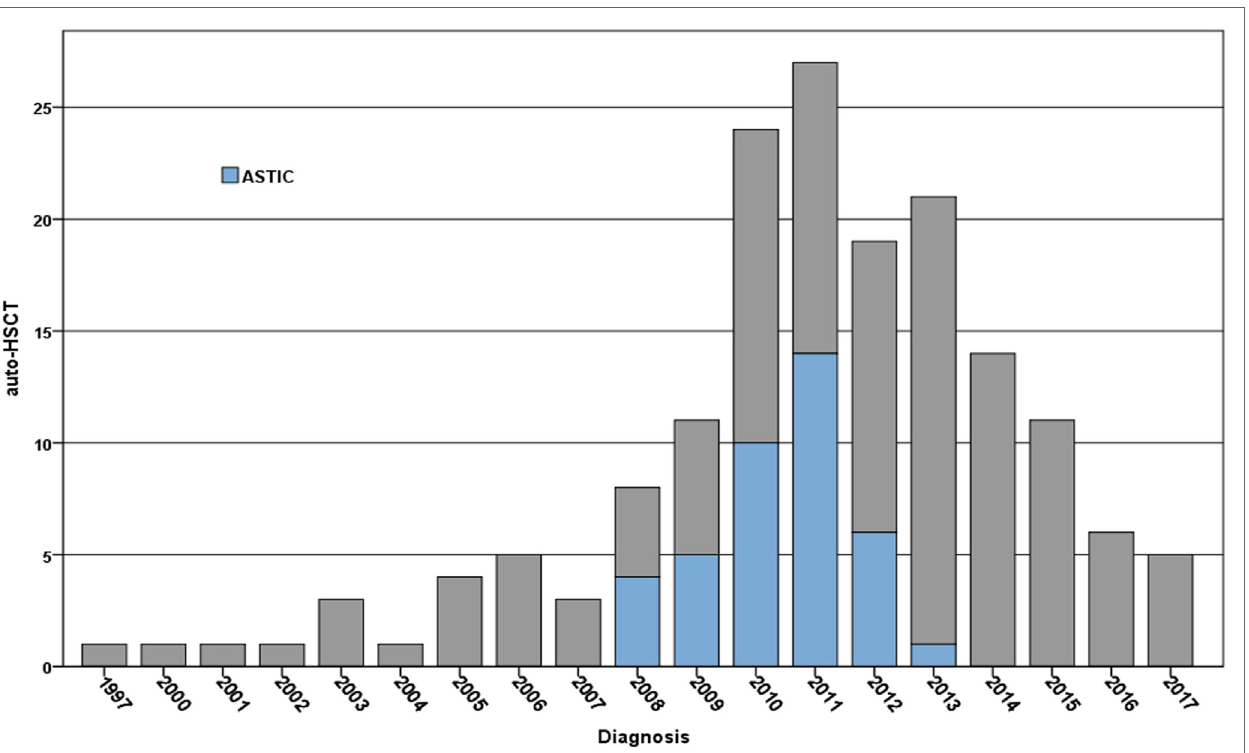
FiGURe 1 | Registrations per year for the treatment of Crohn’s disease using autologous hematopoietic stem cell transplantation (auto-HSCT) within the EBMT registry 1994–2017 (note data for 2017 up to November 2017)—numbers treated on the Autologous Stem cell Transplantation International Crohn’s disease (ASTIC) trial are indicated in blue. Patients have been predominantly treated in Spain, UK, Italy, Belgium, The Netherlands, and France in reducing order (source EBMT Office,